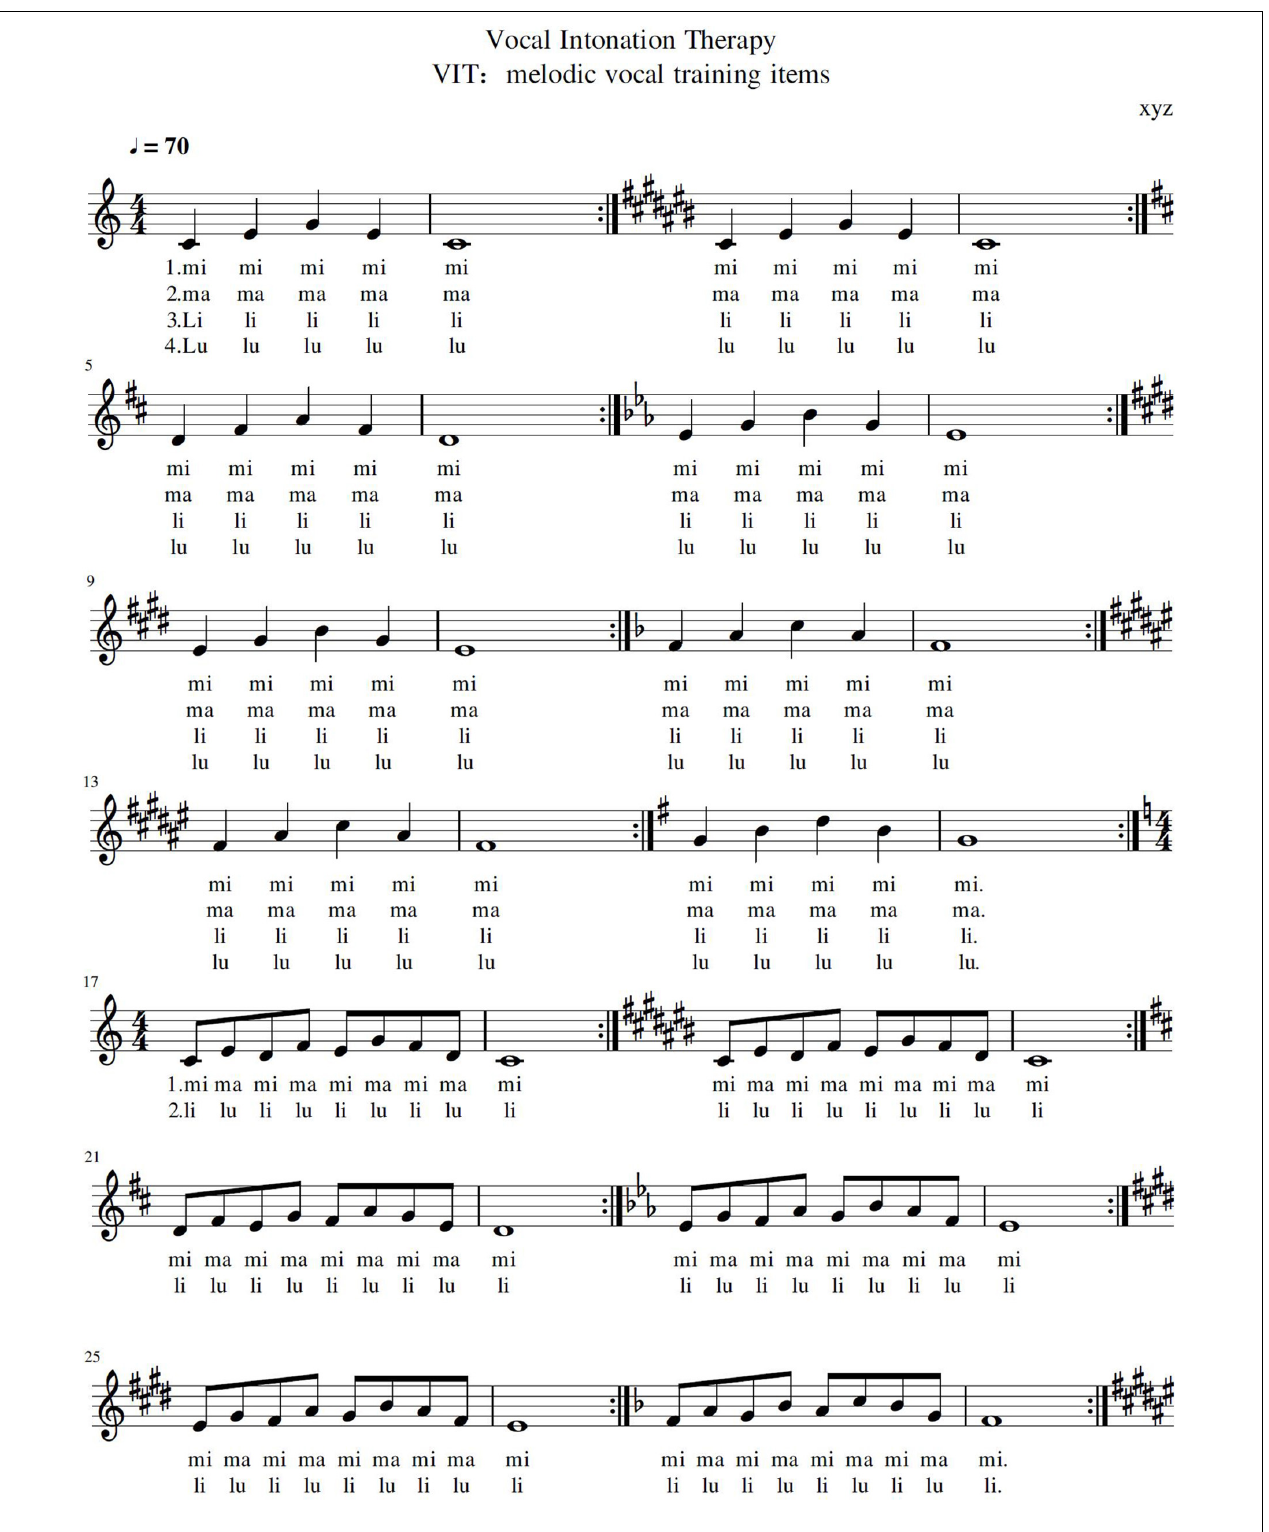
FIGURE 2 | VIT items with different keys, from C to